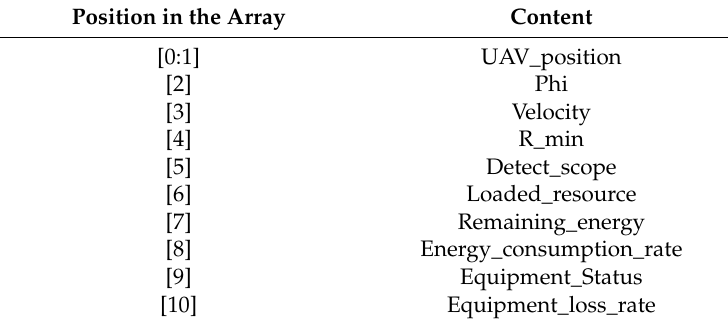
Table 2. Attributes of UAV model.